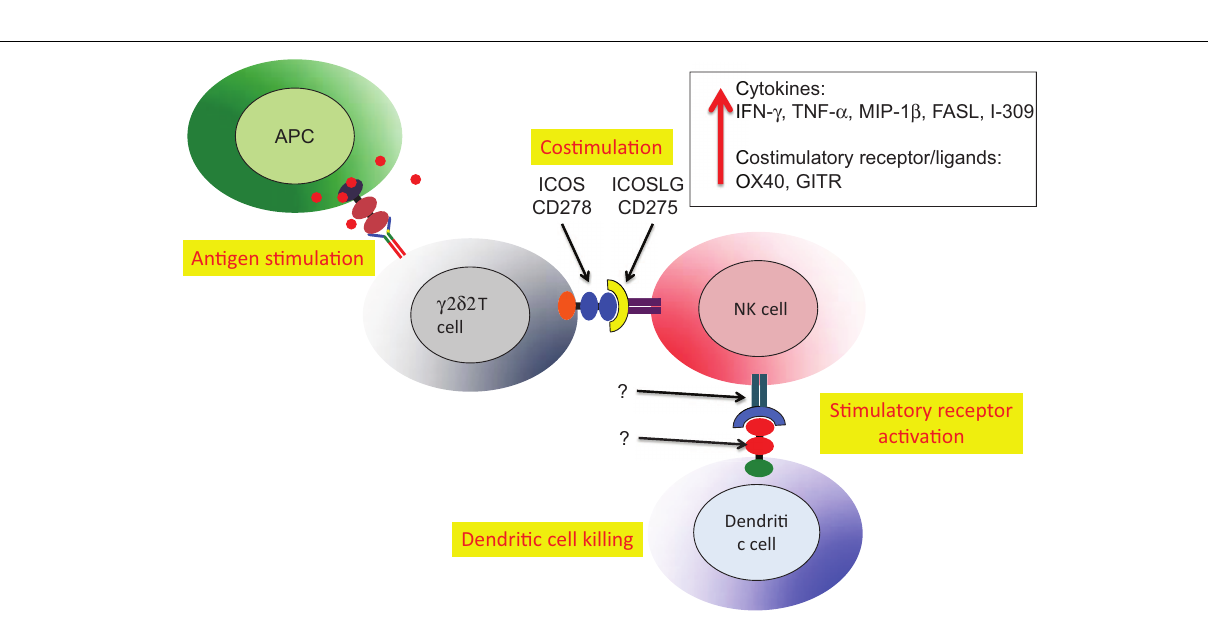
FIGURE 5 |V δ 2 costimulation of NK cells increases lytic effector activity against autologous dendritic cells .TheV δ 2 and NK cells interact through ICOS/ICOSL interactions resulting in upregulation of cytokine expression, increased mRNA for several other costimulatory receptors and increase lytic effector activity against dendritic cells (87).The relevant